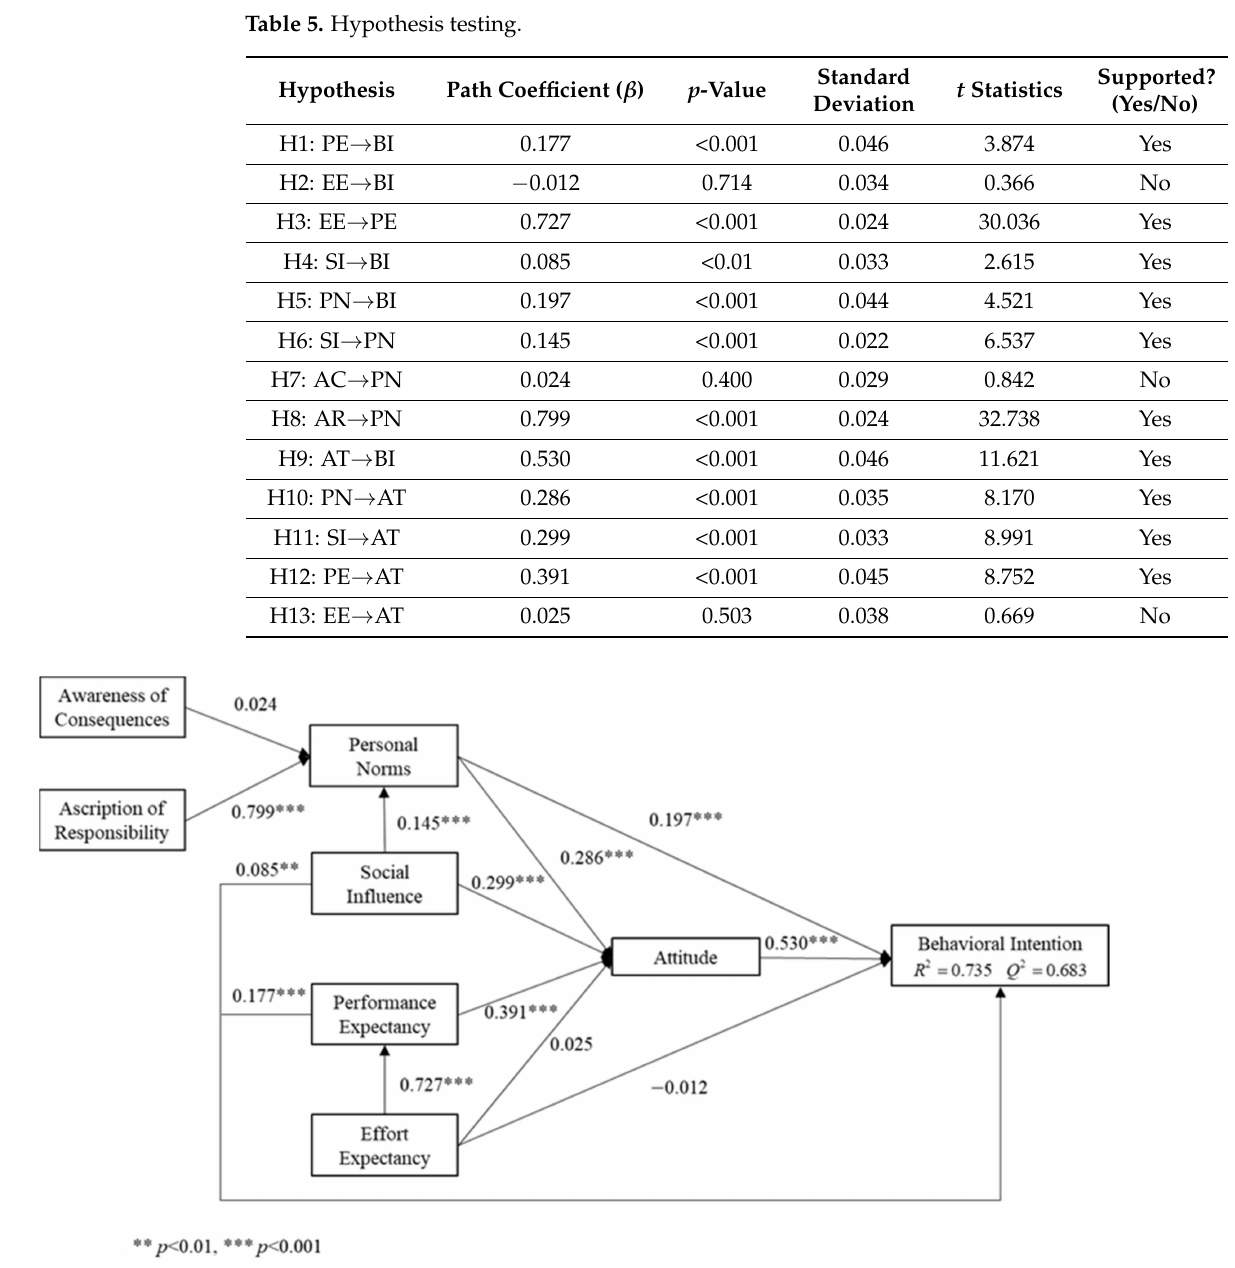
Table 5. Hypothesis testing.